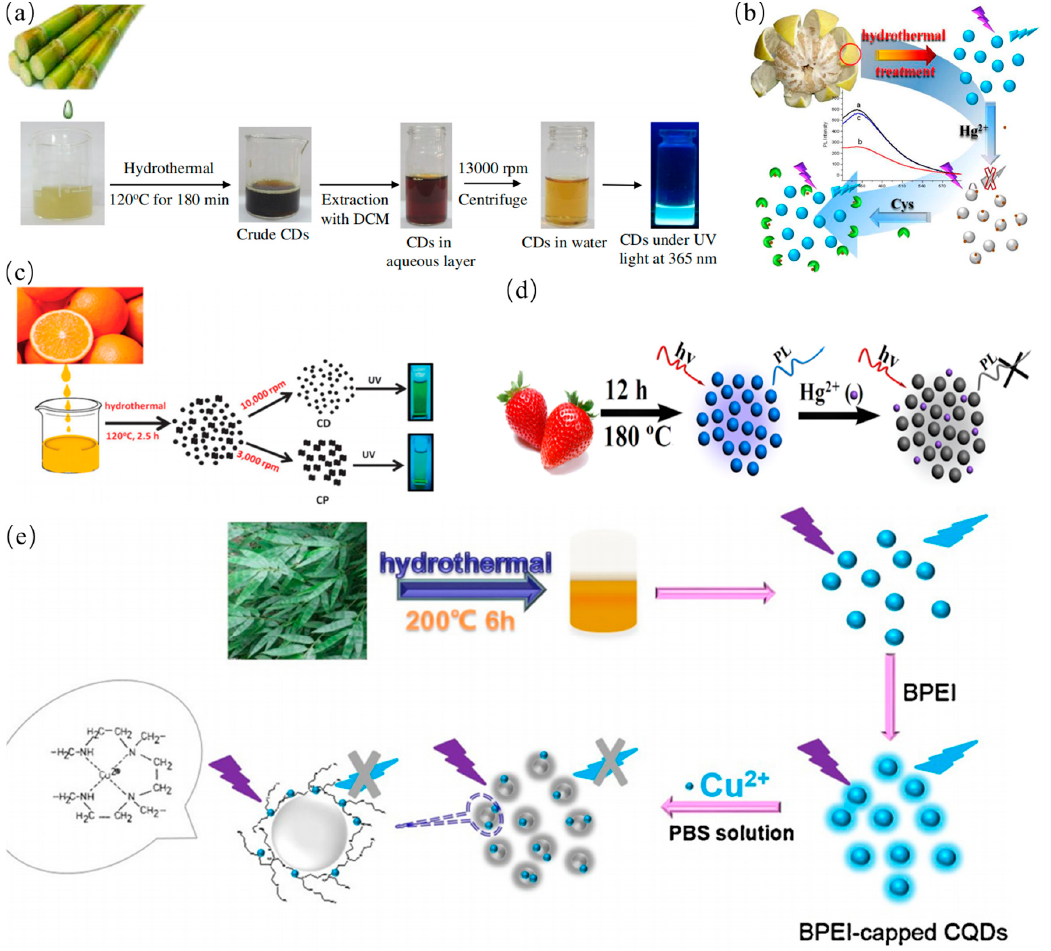
Figure 6. Schematic diagram of ( a ) Preparation process and application of the fluorescence CDs from saccharum officinarum juice [77]. Copyright 2014, Elsevier. ( b ) Synthesis of the CDs derived from pomelo peel [78]. Copyright 2012, American Chemical Society. ( c ) Preparation and application of the soluble CDs from orange juice [79]. Copyright 2012, Royal Society of Chemistry. ( d ) Preparation of the fluorescent CDs from strawberry juice [80]. Copyright 2013, Royal Society of Chemistry. Table 1. Preparation of CDs from various biomass carbon sources and their applications.